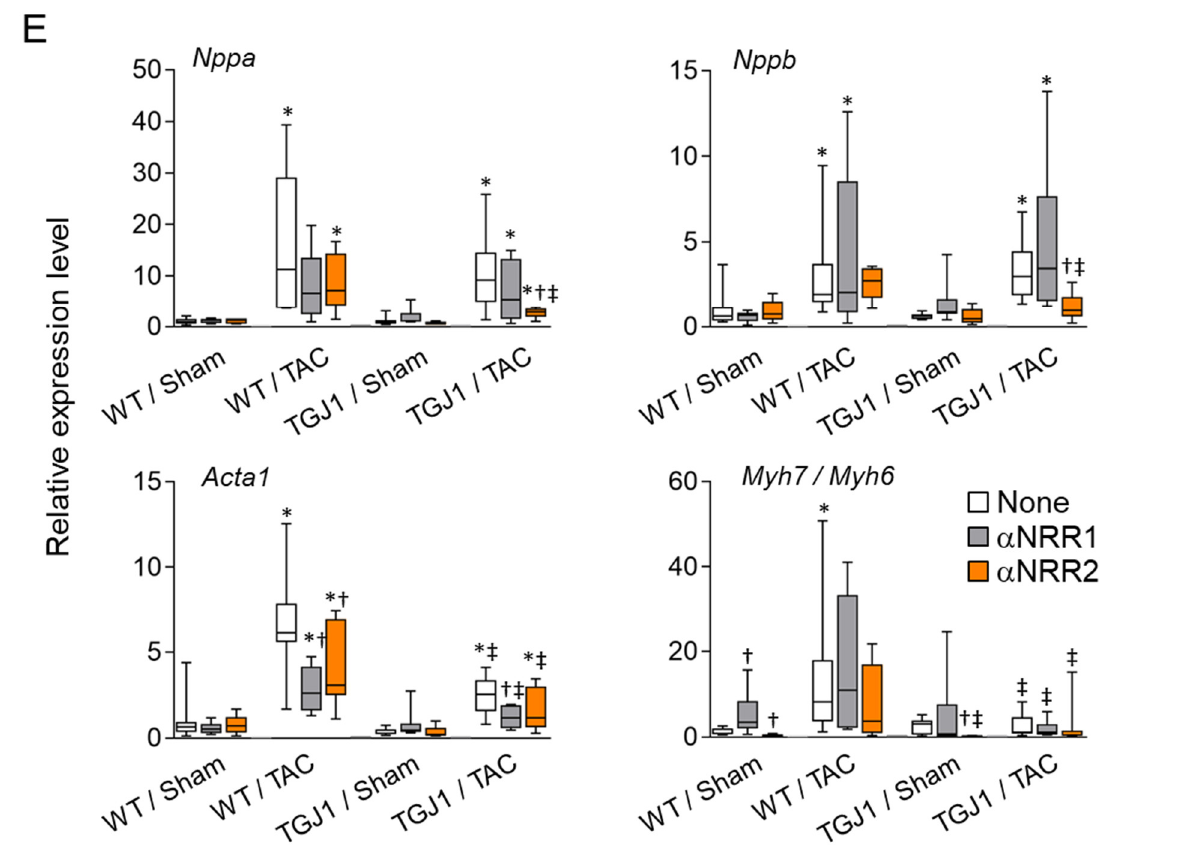
Figure 1. NOTCH1 blocking antibody treatment attenuates cardiac hypertrophy. ( A ) Experimental protocol. TGJ1 mice and WT controls were subjected to Sham or transaortic constriction for two weeks, then treated twice with α NRR1 or α NRR2 antibodies (Ab) at 4 days interval. Untreated mice (none) were also included. BrdU was administered during the first two weeks to label proliferating cells. Hearts were harvested 4 weeks after TAC and analyzed. ( B ) Left ventricle mass-to-body weight ratio in mg/g measured at baseline and week 2 and 4 post surgery. ( C , D ) Progression of percent ejection fraction (%EF) from baseline to week 4, in Sham ( C ) or TAC ( D ) operated mice. ( E ) RT-PCR analysis of expression of cardiac stress marker genes Acta1, Nppa, Nppb and Myh7/Myh6 ratio. The graphs represent expression values relative to untreated, Sham-operated group; n = 5–10 animals/group (see Supplementary Table S2). *, p < 0.05 in TAC vs. Sham; †, p < 0.05 in α NRR vs. None; ‡, p < 0.05 in TGJ1 vs.